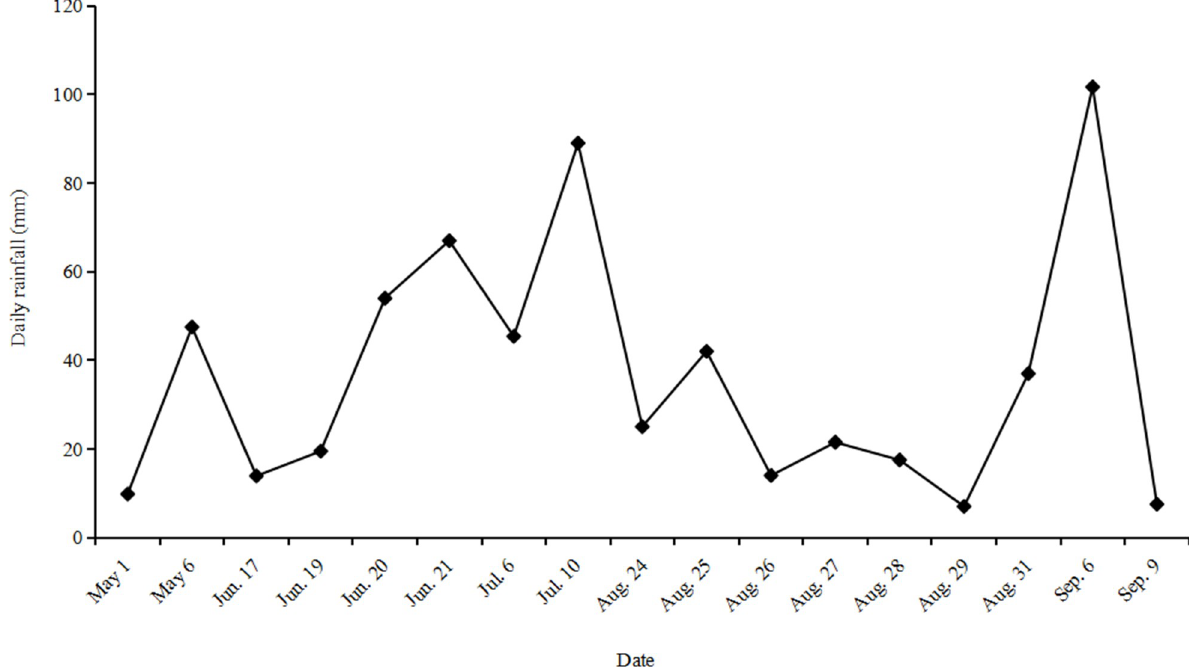
Fig 2. Characteristics of 17 rainfall-runoff events in the experiment plots from May to September